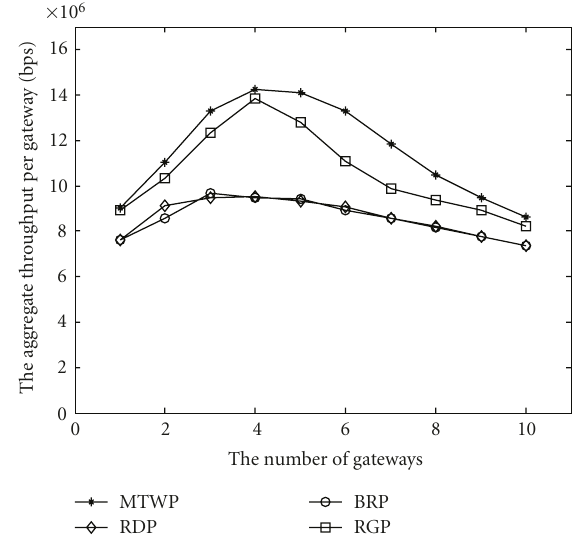
Figure 14: The comparison of the aggregate throughput per gateway with uniformly distributed mesh clients.